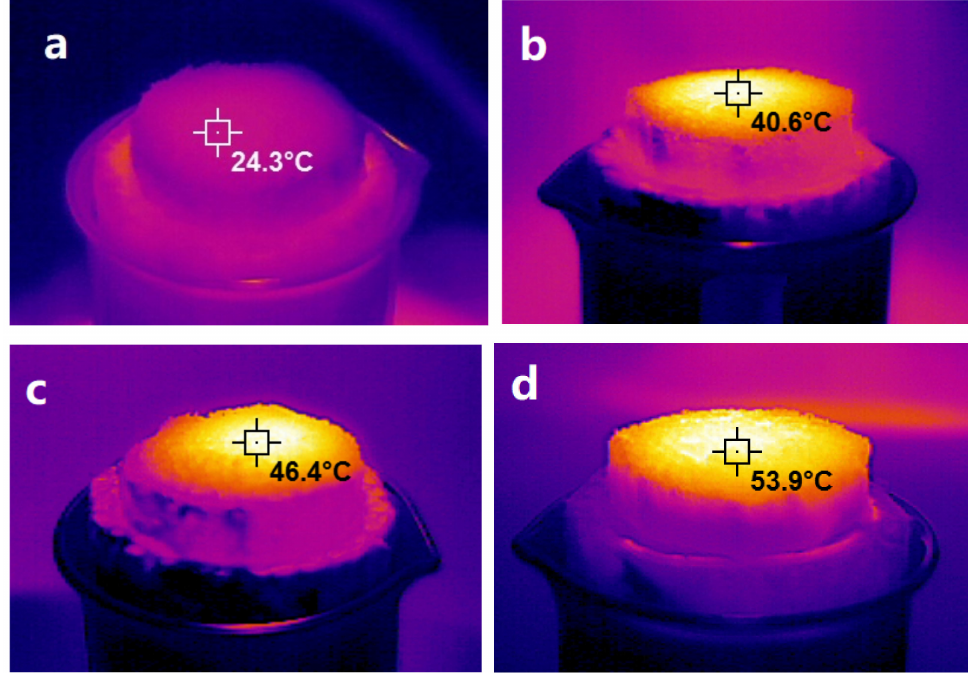
Figure 6. Infrared thermography of NRS (( a ), 1 sun) and PNRS (( b ), 1 sun; ( c ), 2 sun; ( d ), 3